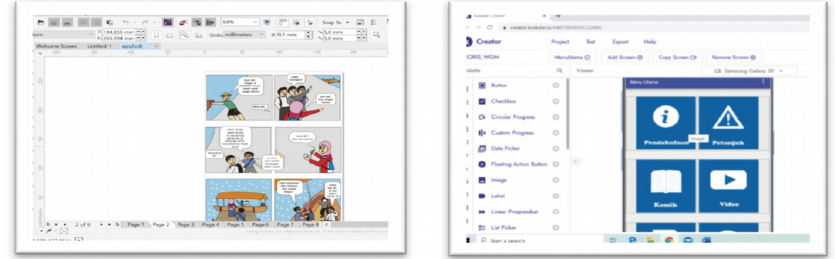
Figure 3. Making a comic using Coreldraw and application using